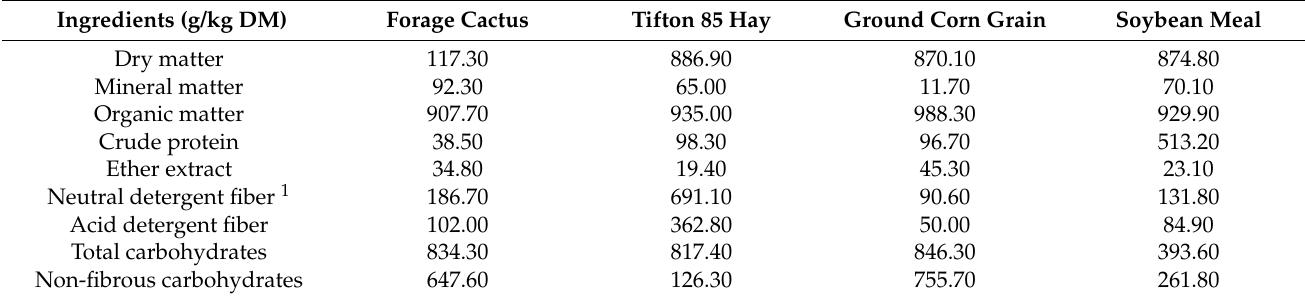
Table 1. Chemical composition of diets ingredients in a dry matter